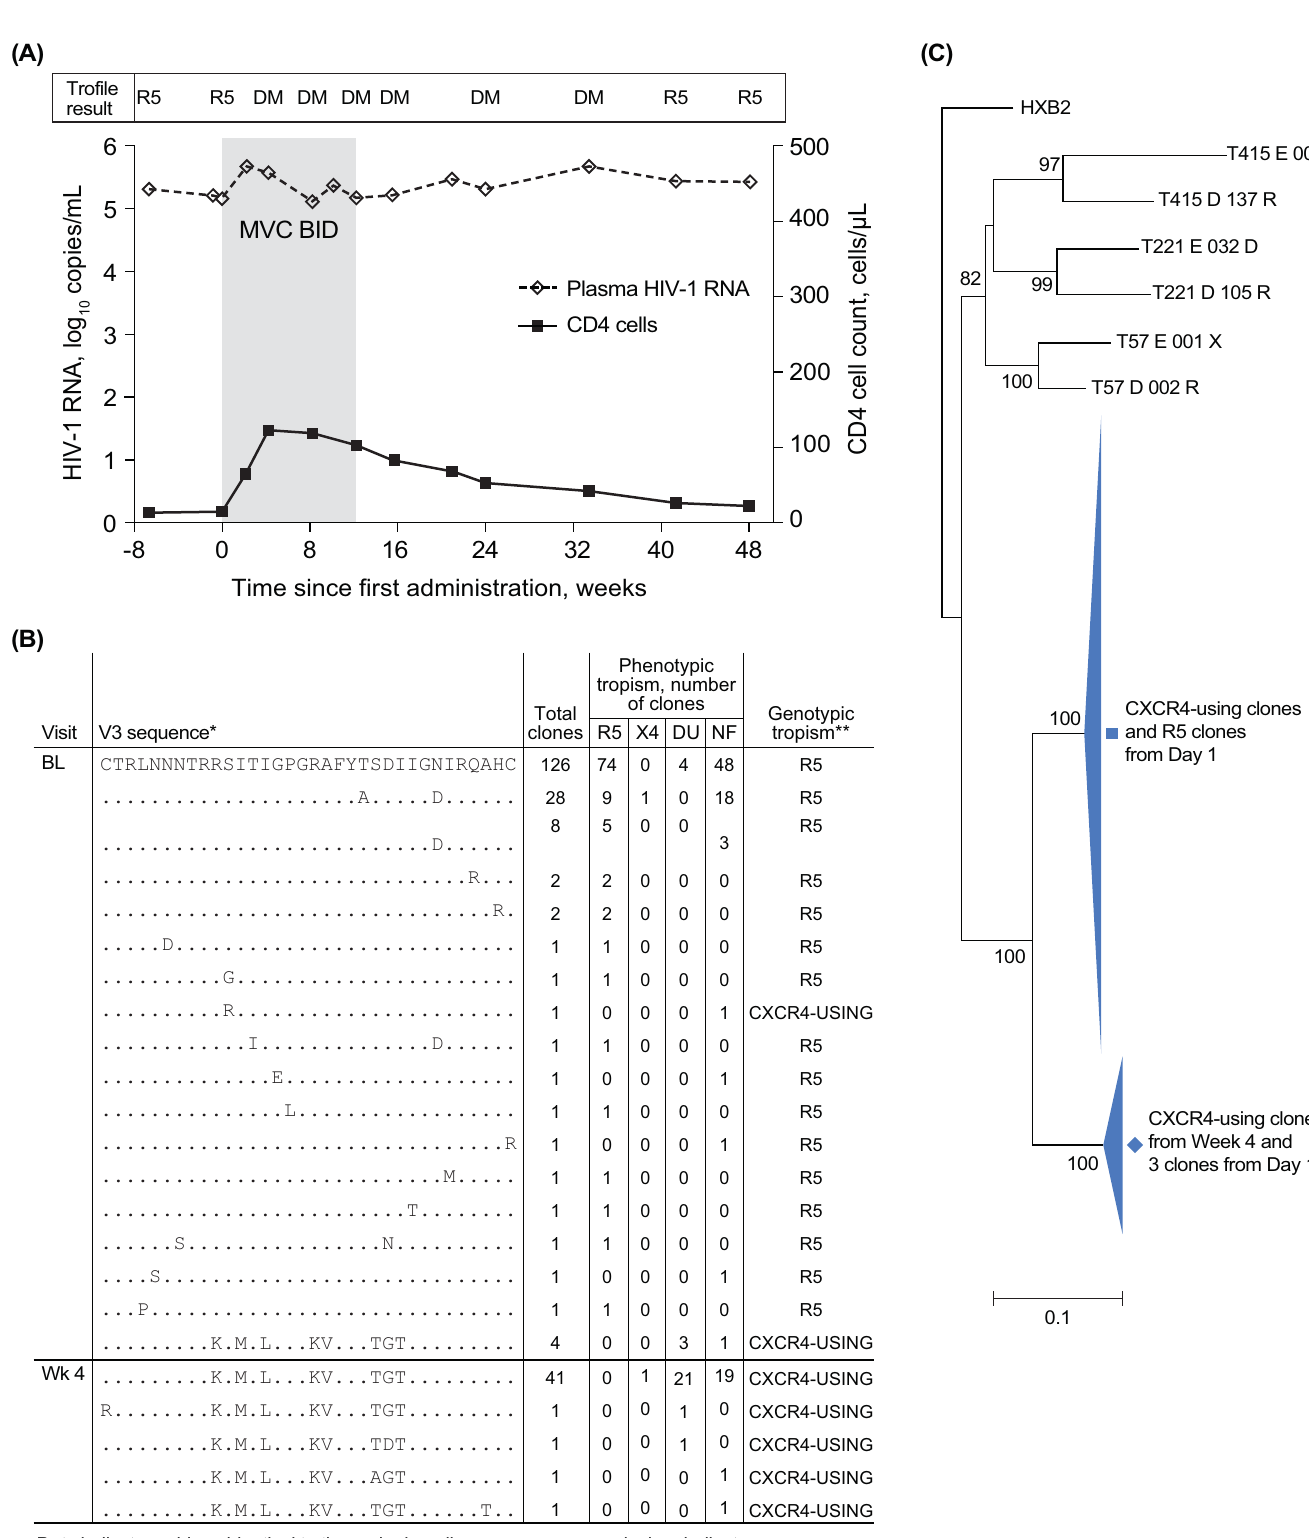
Dots indicate residues identical to the major baseline sequence envs; dashes indicate gaps. *gp120 V3 loop sequence (equivalent to position 296 to 331 in HXB2 NCBI accession number K03455). **Genotypic tropism was assessed using the Geno2Pheno analysis with cut-off <10%